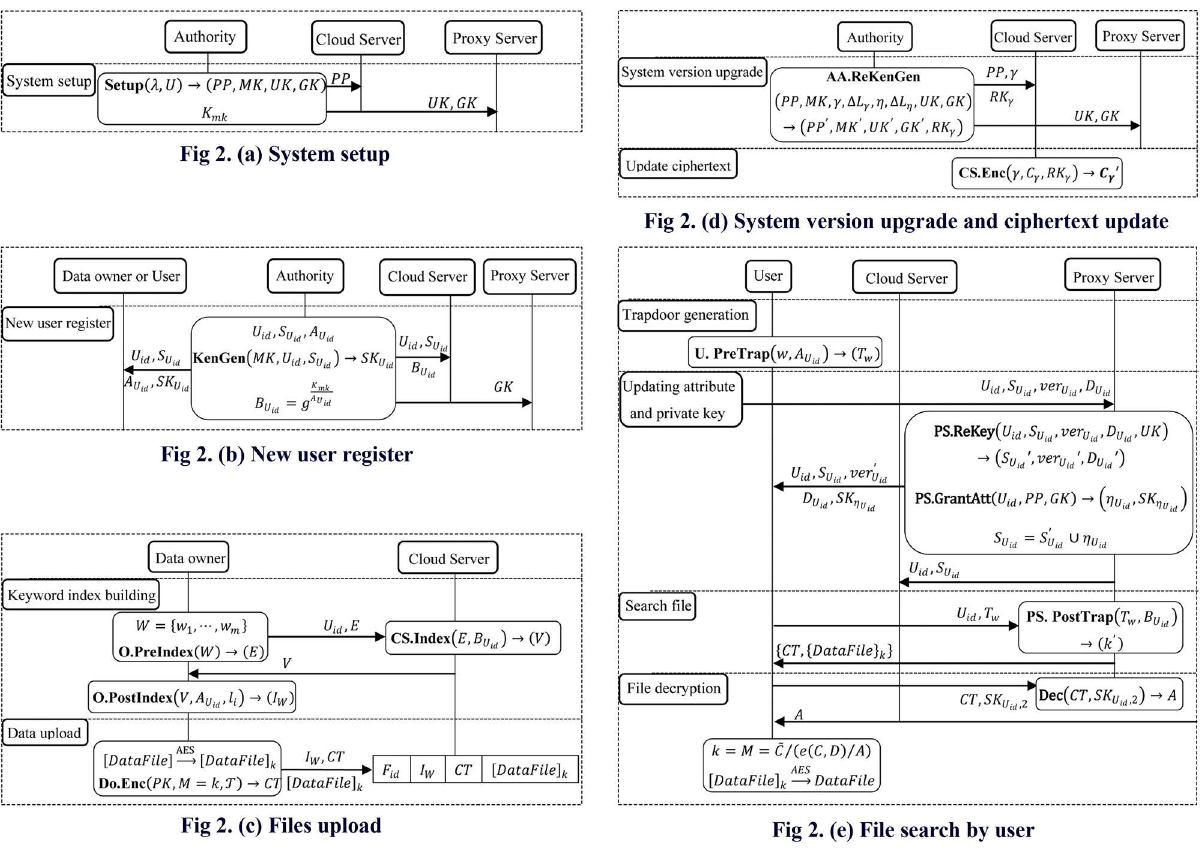
Fig 2. Flowchart of Our Proposed